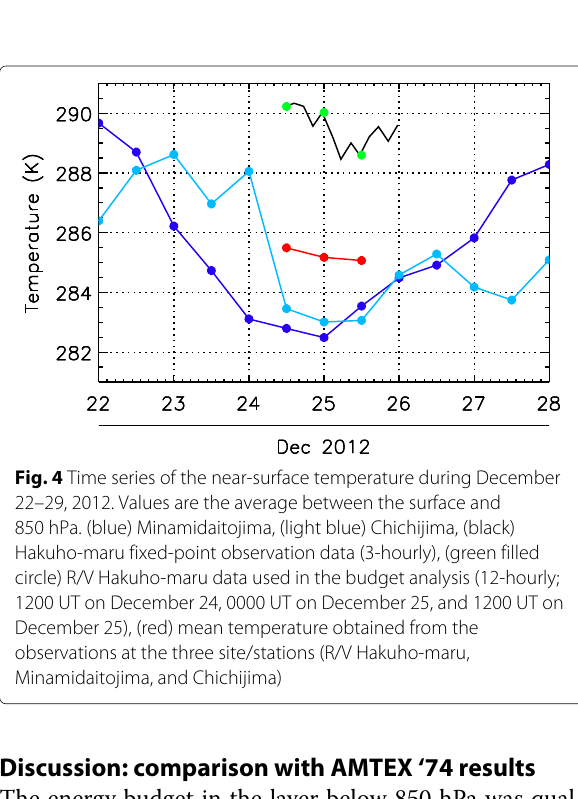
(cid:6) (cid:7) ∂ T /∂ p − R / C / p (green), and individual change in temperature δ T /δ t (red). (Right) The p T